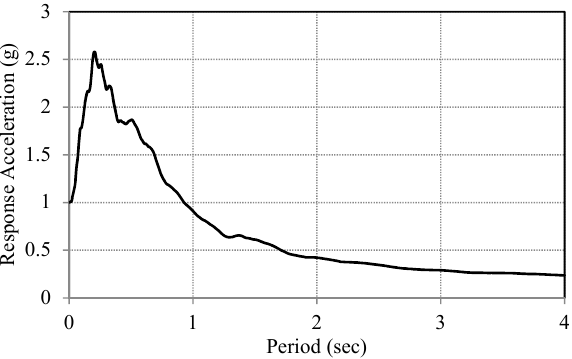
Figure 13. The average response spectrum of selected ground motions.